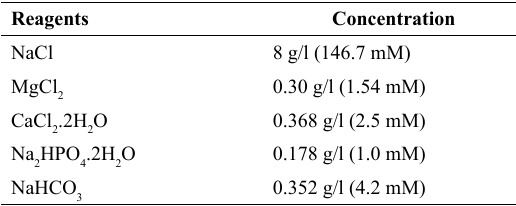
Table 1. SBF chemical composition.